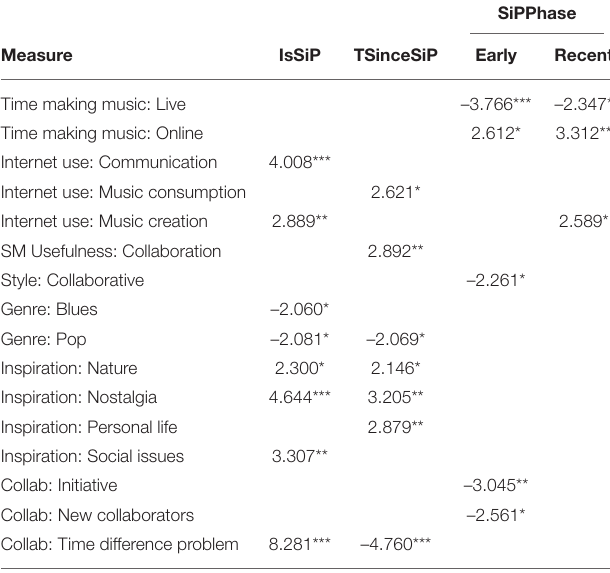
TABLE 3 | Correlation matrix for pandemic-related